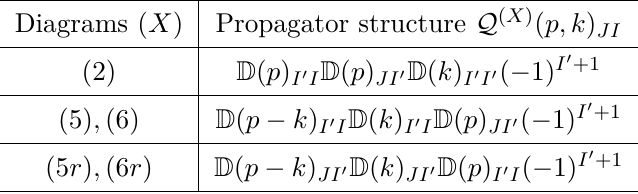
Table 3. Summary of propagator structures of diagrams with 3 propagators contributing to (cid:2) (cid:3) da g ++ . Summation over repeated I 0 indices is implicit, even when there are three or more E ji,JI instances of such